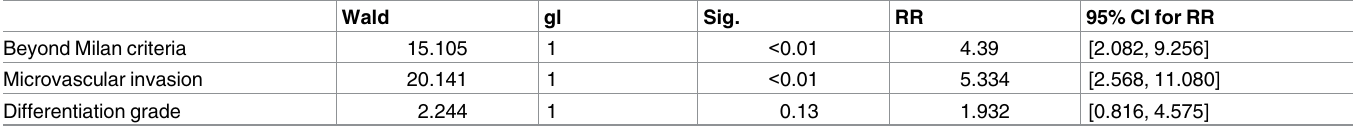
Table 4. Multivariate Cox’s regression showing independent predictors of recurrence-free survival after liver